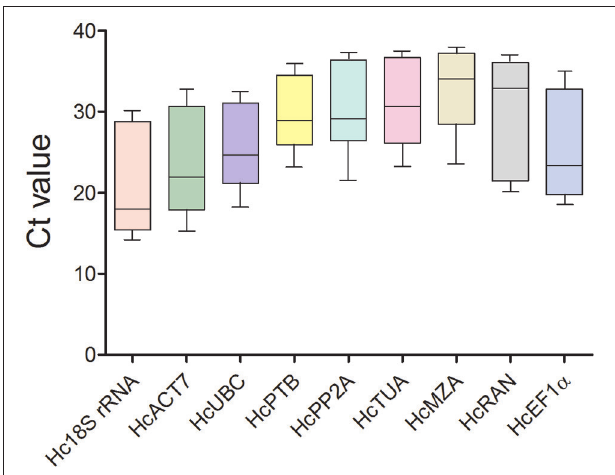
FIGURE 1 | Ct values of 9 candidate reference genes in all experimental samples. The box indicates 25th and 75th percentiles. Lines across the box depict the median value. The whiskers represent the 5th and 95th